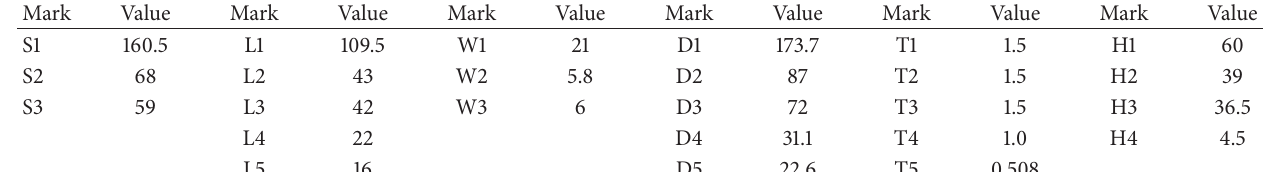
Table 2: Main design parameters of element antennas [ unit: mm ] .